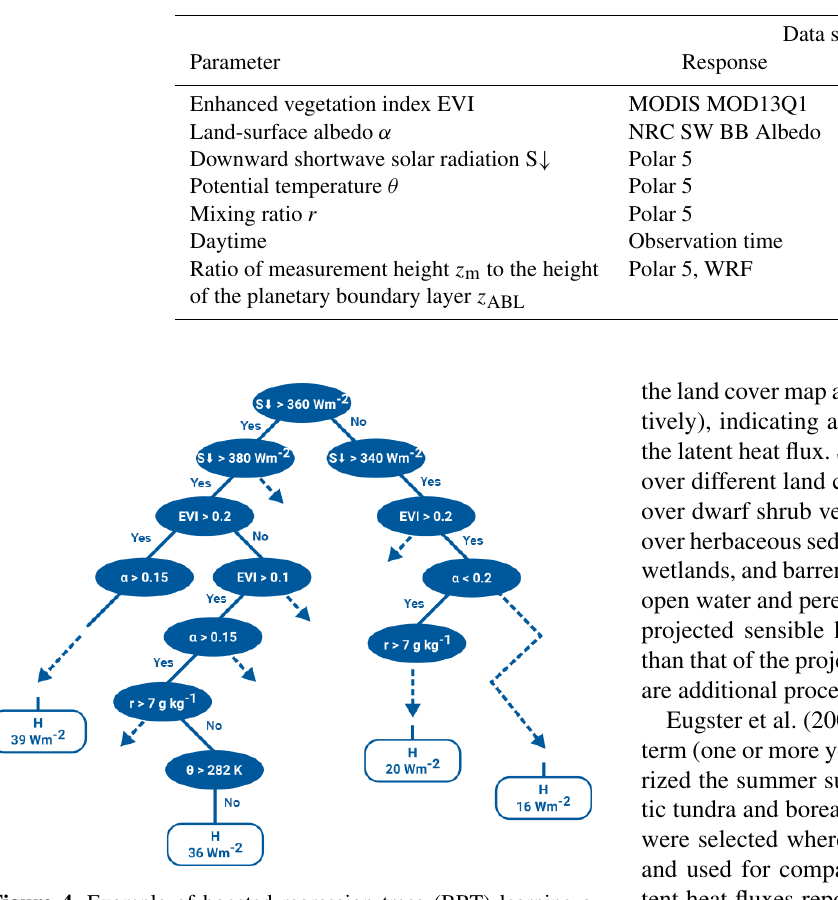
Figure 4. Example of boosted regression trees (BRT) learning a response of sensible heat flux ( H ) to observations of the down- ward shortwave solar radiation (S ↓ ), the enhanced vegetation in- dex (EVI), the mixing ratio ( r ), and the land-surface albedo ( α